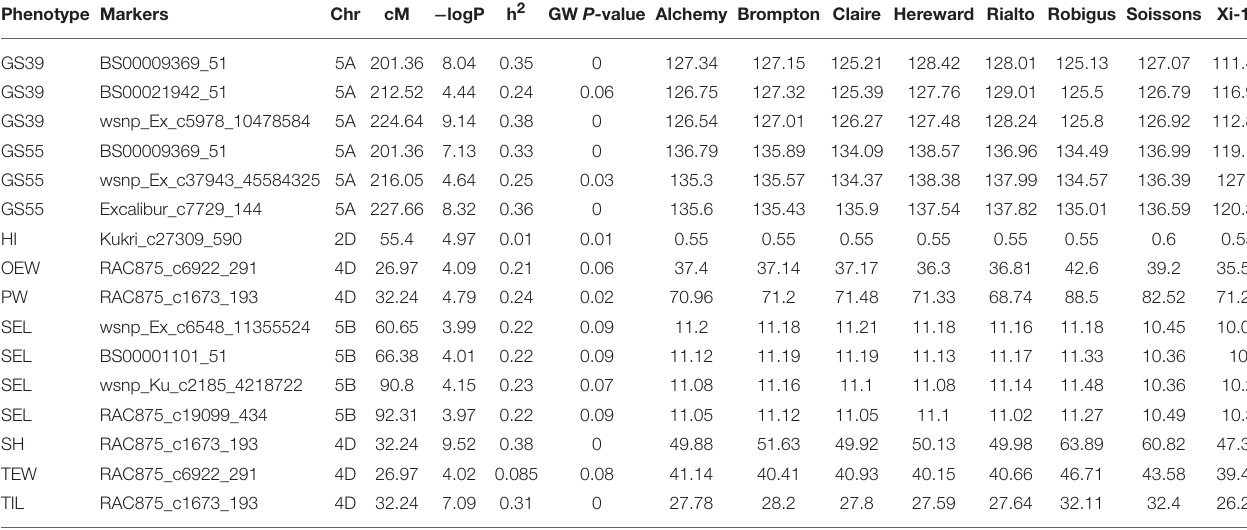
TABLE 2 | QTLs mapped for different traits.